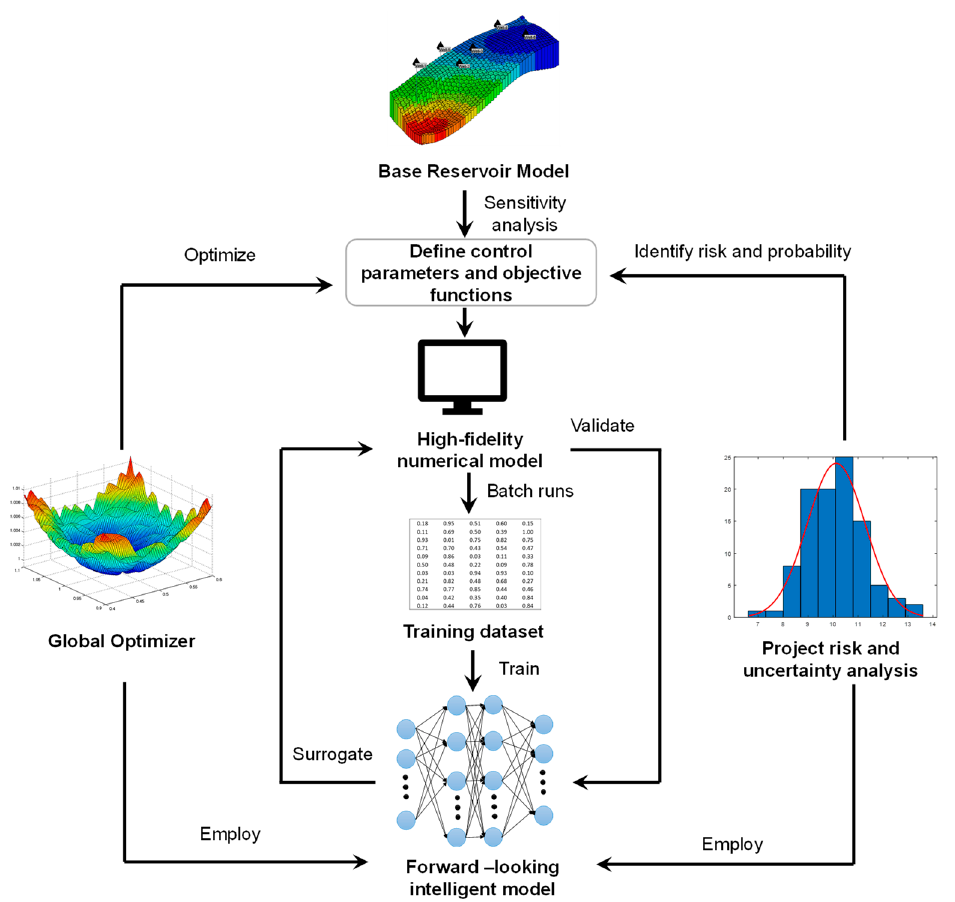
Figure 2. General workflow that uses forward-looking intelligent models to accomplish computationally intensive reservoir engineering analysis.